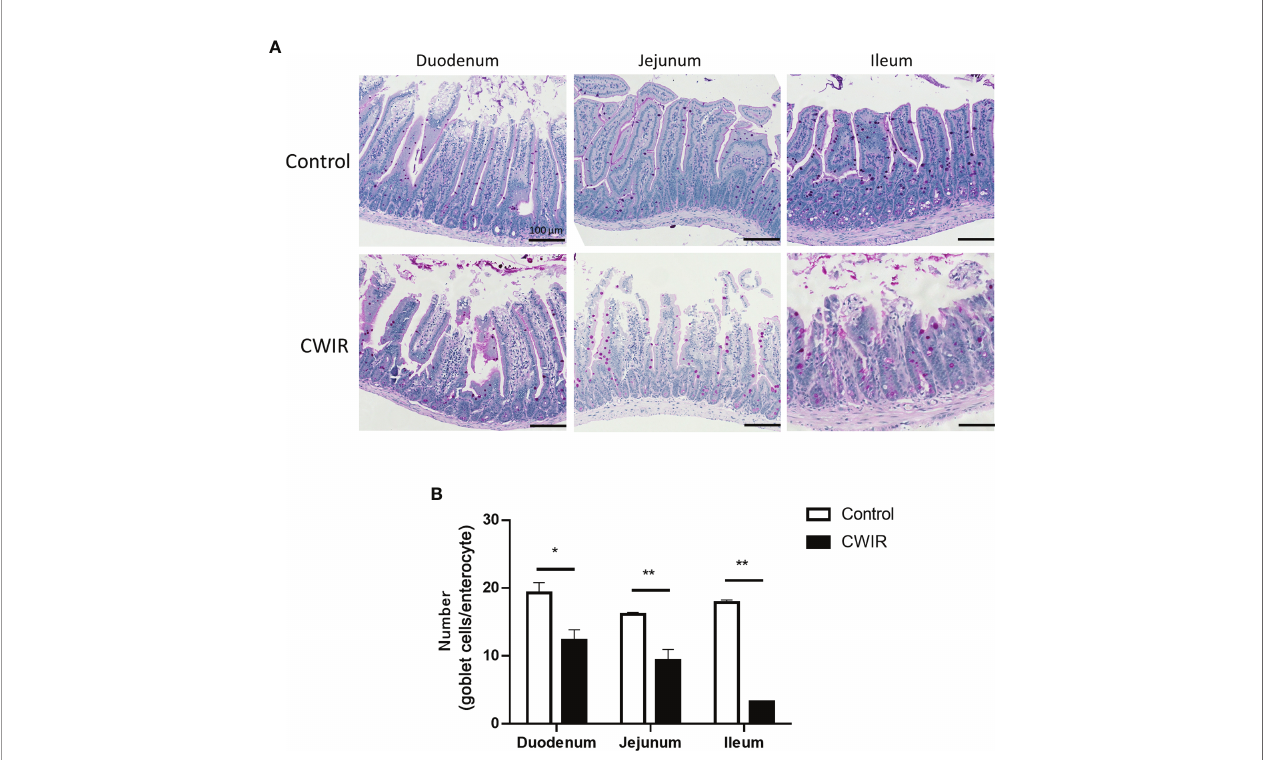
FIGURE 2 | Histology of mouse intestine stained with periodic acid-Schiff (PAS) reagent. (A) Representative images of PAS-stained goblet cells in the small intestine (magni fi cation, 200×). PAS stains carbohydrates in pink color. Scale bar = 100 m m. (B) Numbers of goblet cells analyzed on the PAS-stained sections of the duodenum, jejunum, and ileum of mice following CWIR or control treatment. All data are shown as the mean ± SEM (n = 4 – 5 per group). * P < 0.05, ** P < 0.01 vs. WT